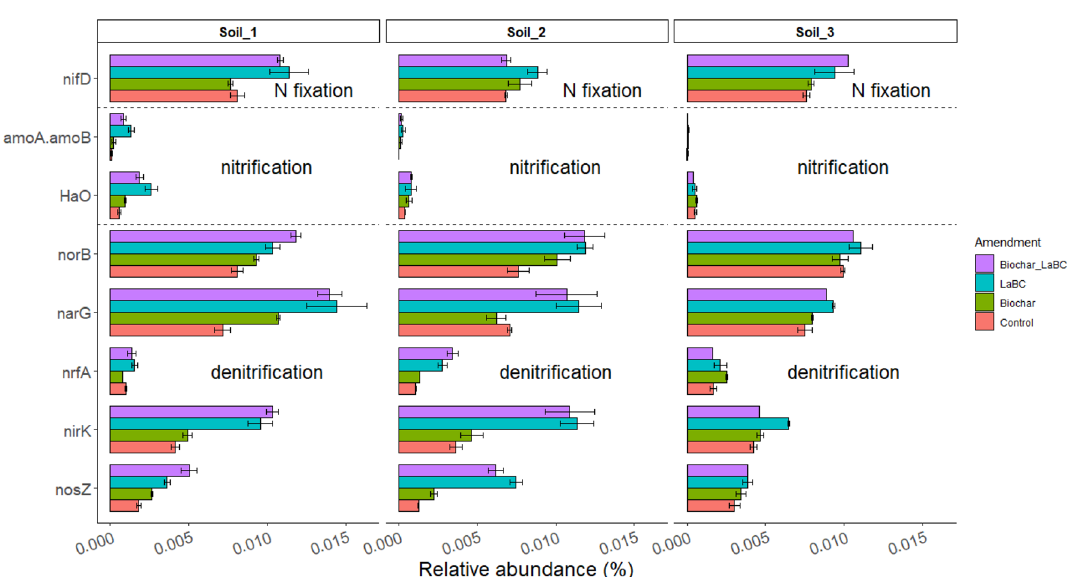
Figure 5. Predicted N gene count (PICRUSt) for the most abundant N cycling genes detected in three soils of contrasting textures (Soils 1, 2 and 3; sand, sandy loam and clay respectively) amended with LaBC, Biochar and Biochar + LaBC after 8 weeks with subterranean clover. Bars represent the mean of each treatment and error bars are the standard error of the mean (n =